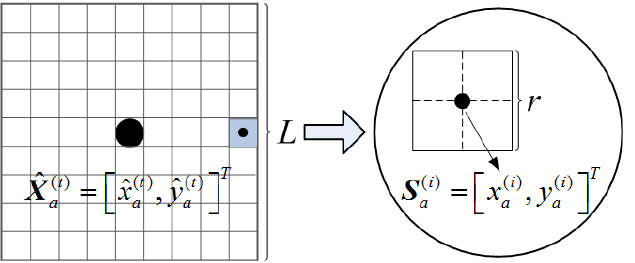
Figure 9. Samples for localization